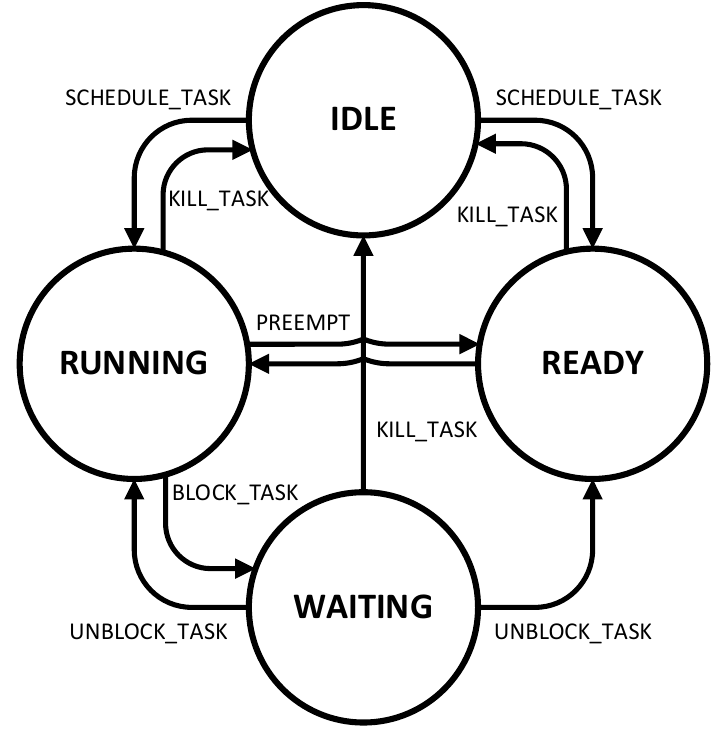
Figure 7. State diagram of task states.